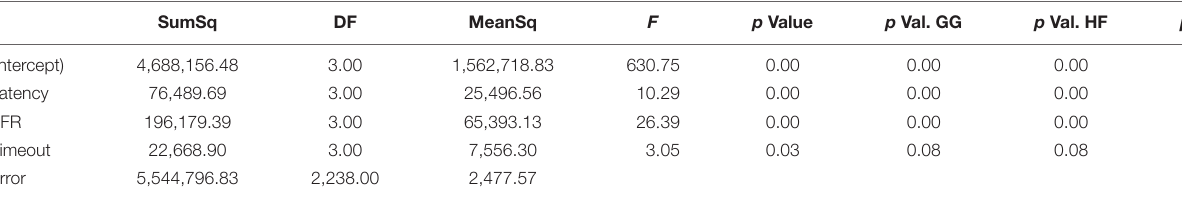
TABLE 2 | Repeated-measures ANOVA for primary CBI parameters.